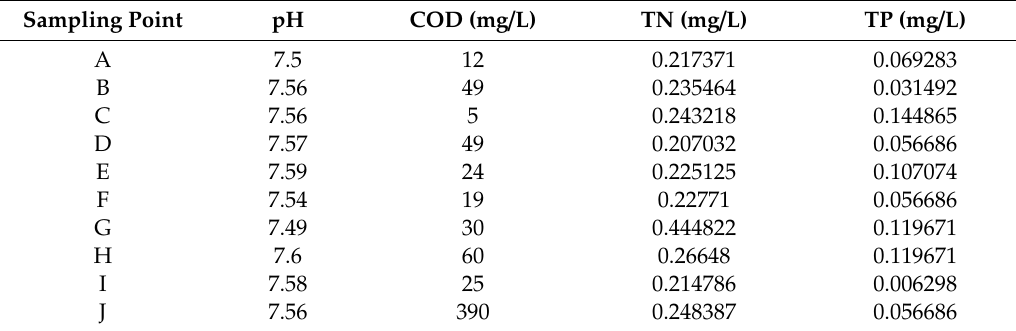
Table 2. Test results of various indicators.